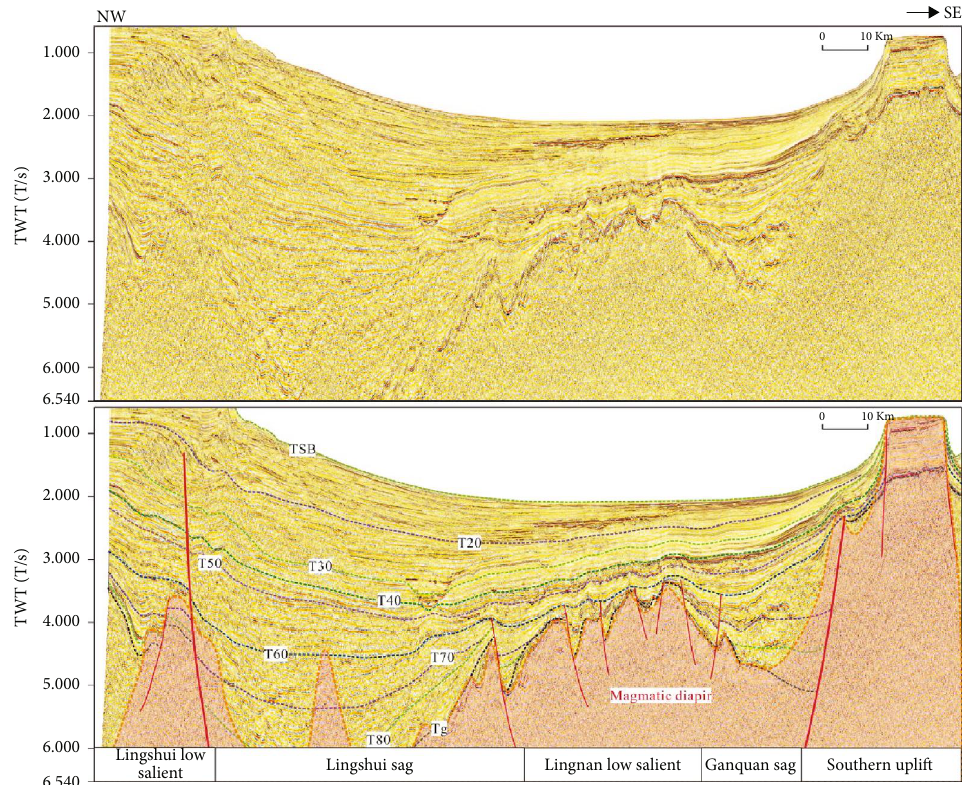
Figure 9: Seismic pro fi le showing the characteristics of the Paleogene magmatism in Western QDNB (pro fi le location of line 4 is shown in Figure